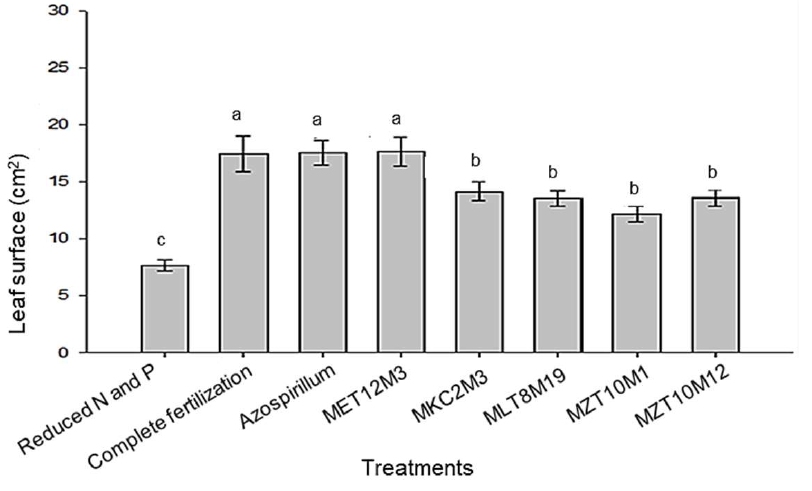
Figure 9. Leaf area of plants inoculated or not with in vitro selected endophytic bacteria. Means represented by the same letter do not differ significantly by the Scott–Knot test at 5% probability.